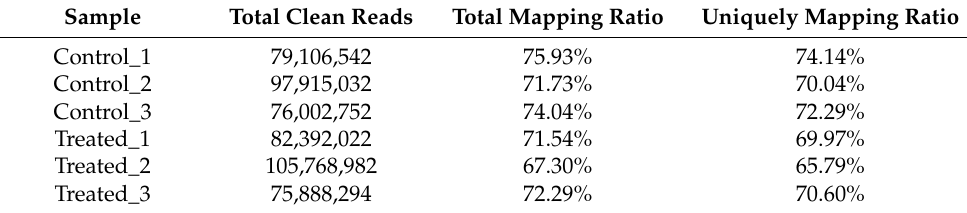
Table 2. Statistics of read align to reference genome.